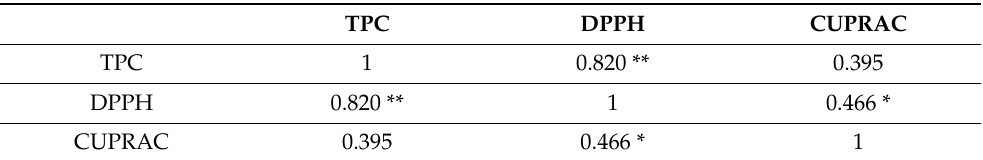
Table 2. Pearson correlation matrix of the TPC and antioxidant capacities of probiotic whey beverages enriched with kiwi